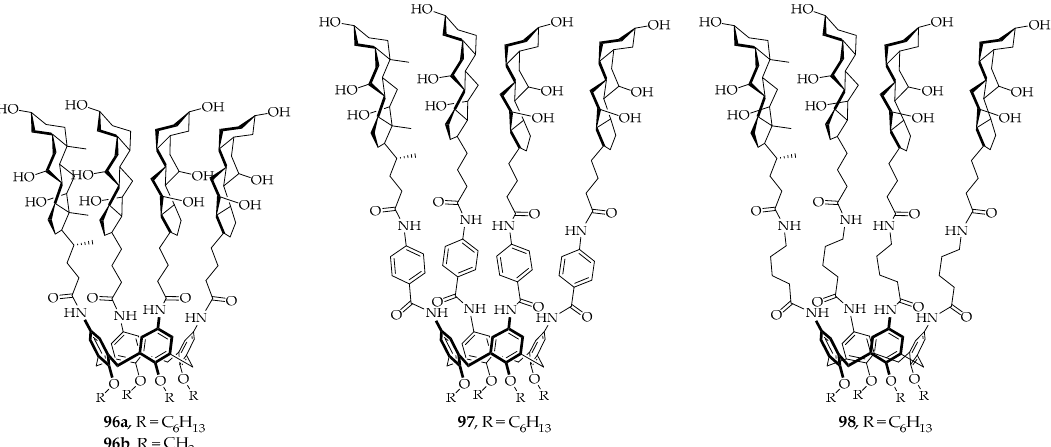
Figure 10. Structures of amphiphilic calix[4]arenes containing cholesterol fragments 96a-b , 97 , 98 .